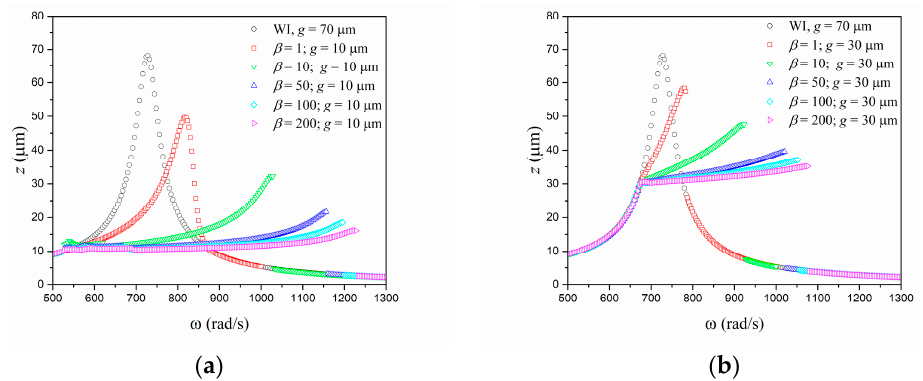
Figure 3. Maximum displacement versus forcing frequency: comparison between linear model without impacts ( 𝑔 = 70 μ m) and a system incorporating impacts with different values of 𝛽 : ( a ) 𝑔 = 30 μ m; ( b ) 𝑔 = 10 μm.